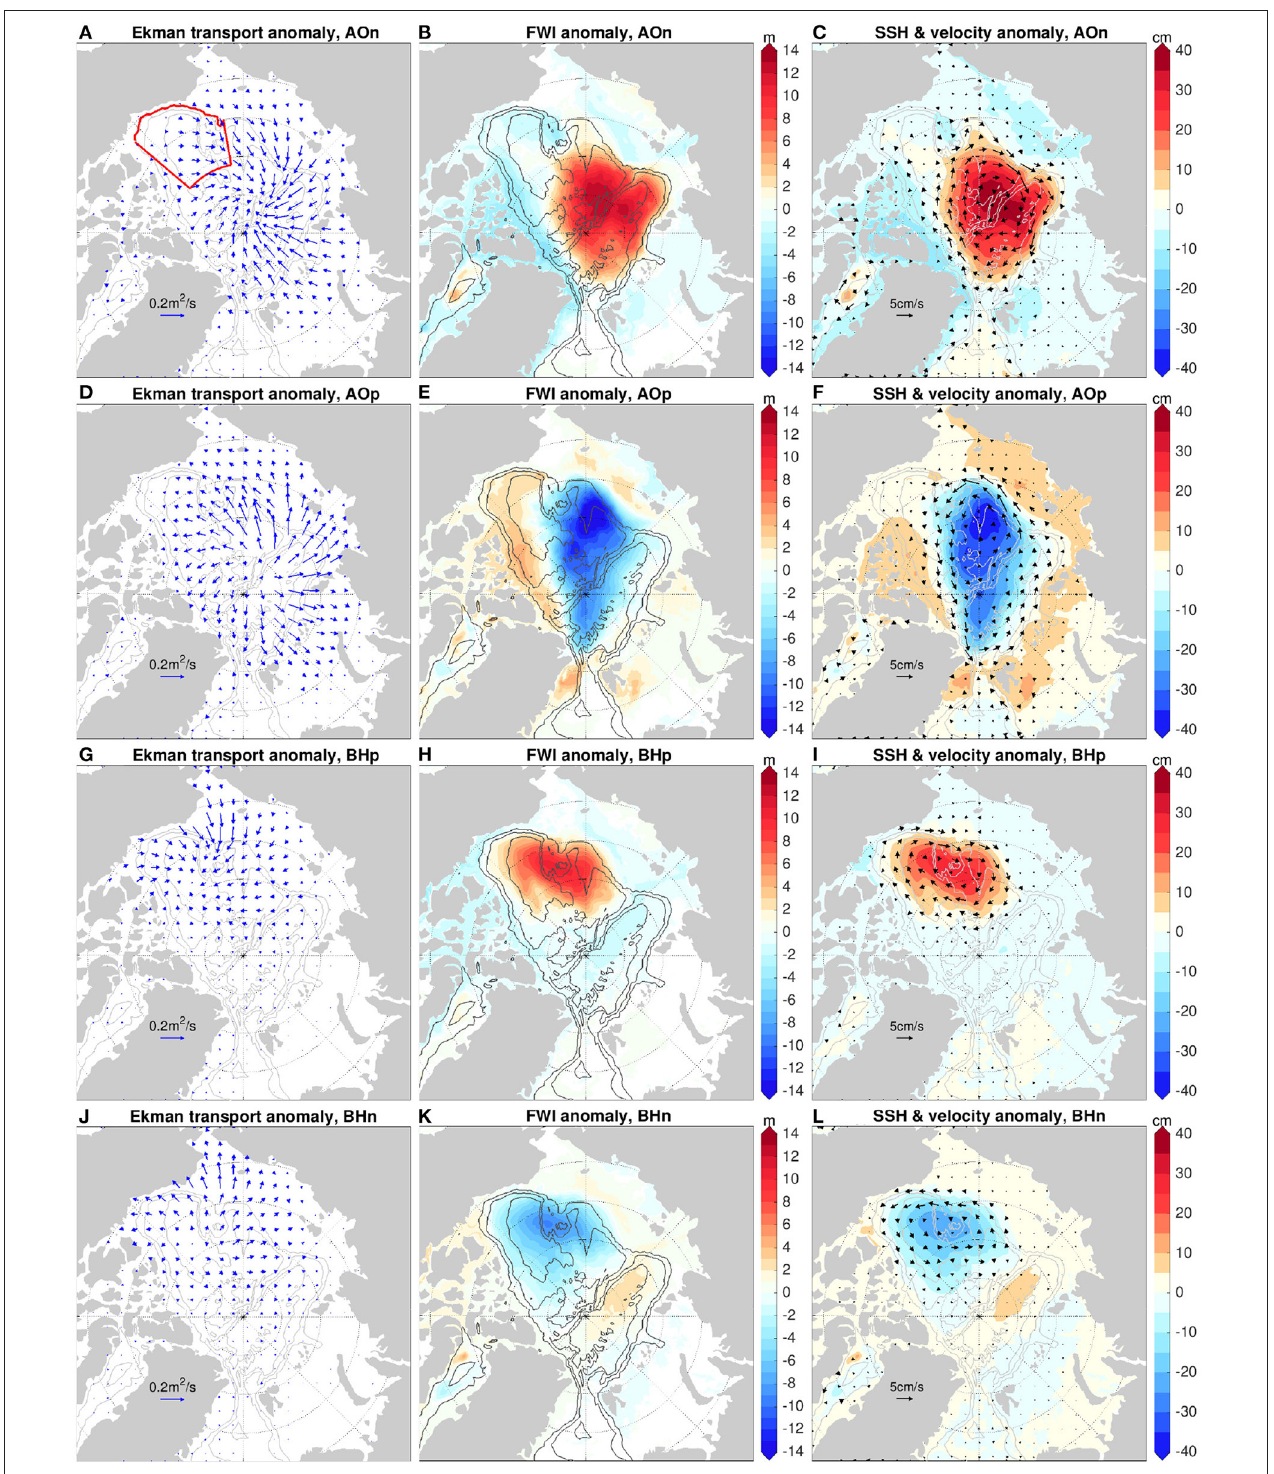
FIGURE 4 | (A) Anomaly of surface Ekman transport with negative Arctic Oscillation (AO) forcing relative to the control run averaged over the 10 model years. (B) Anomaly of freshwater inventory (FWI, in m) with negative AO forcing relative to the control run averaged over the last model year. (C) Anomalies of sea surface height (SSH) and upper 150 m mean velocity with negative AO forcing relative to the control run averaged over the last model year. (D–F) The same as (A–C) , but for the case with positive AO forcing. (G–I) The same as (A–C) , but for the case with positive Beaufort High (BH) forcing. (J–L) The same as (A–C) , but for the case with negative BH forcing. The 500, 2,000, and 3,500 m isobaths are shown with gray contour lines.